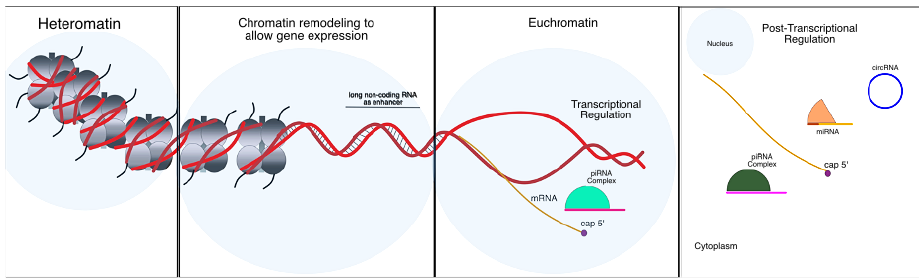
Figure 2. Mechanisms of gene expression regulation. Gene expression is regulated by a network which includes chromatin modulators, with the addition of molecules such as acetyl and/or methyl in histones and the methylation of DNA strands. Additionally, ncRNAs participated in several steps both in transcriptional and post-transcriptional levels. Within the nucleus, ncRNAs may play the role of enhancers, transcription factors or as gene silencing tools. In cytoplasm, they may inhibit RNA translation or modulate the action of other ncRNAs and be used as a sponge of RBP, inducing mRNA degradation.